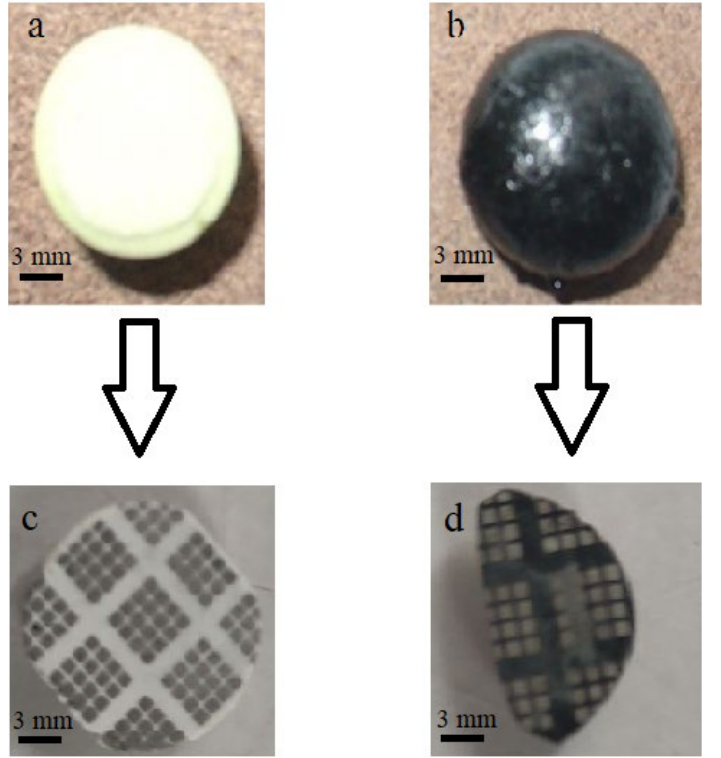
Figure 1. Photo of samples C12A7:O 2− ( a , c ) and C12A7:e − ( b , d ) made before ( a , b ) and after ( c , d ) deposition of nickel contacts.